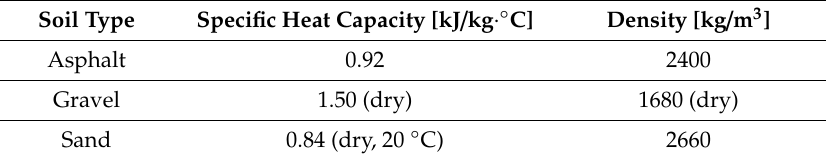
Table 3. Some physical properties of the soil in the literature [7,24–26].